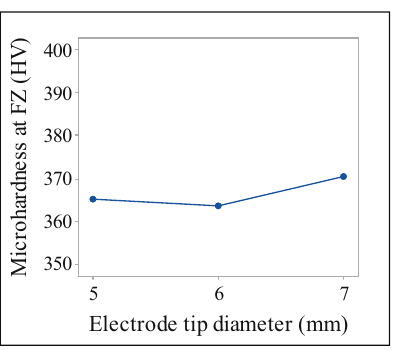
Figure 7: Effect of electrode tip diameter and welding current on peak load of tensile shear